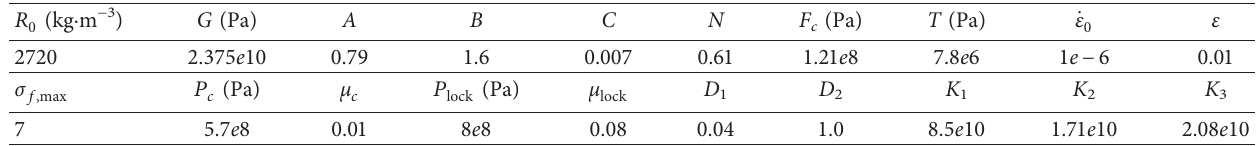
Figure 2: The numerical simulation model of conical pick cutting arc rock plate. Table 1: The key parameters of the JHC constitutive model.